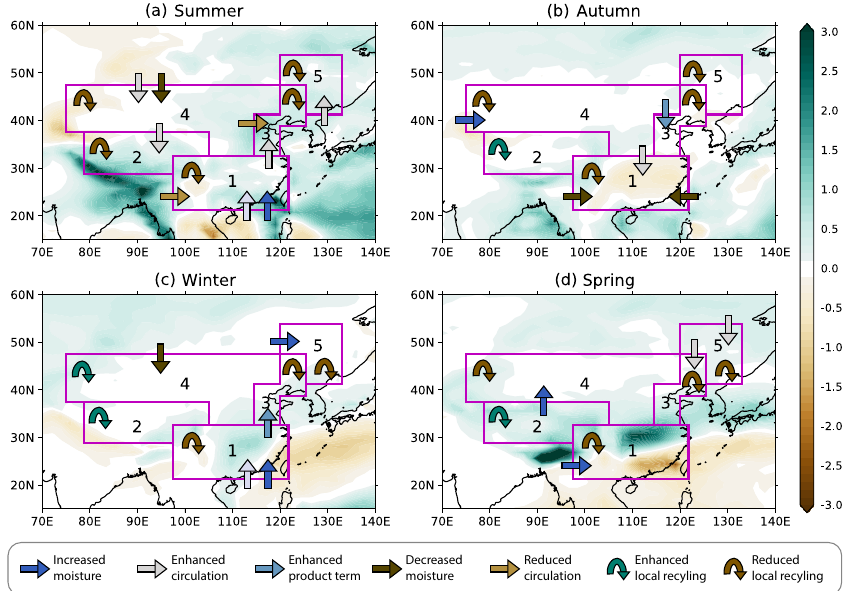
Figure 13. Summary schematic showing the major contributions (coloured arrows) to the seasonal- mean ensemble-mean precipitation changes (mm day − 1 ; shaded) between P30 and CON for ( a ) Sum- mer (JJA), ( b ) Autumn (SON), ( c ) Winter (DJF) and ( d ) Spring (MAM). During the summer season, the significant increase in the contribution to EASM precipitation over most of EA, except southeastern EA, is due to enhanced circulation from the south for eastern EA and from the north for western EA (Figure 13a).